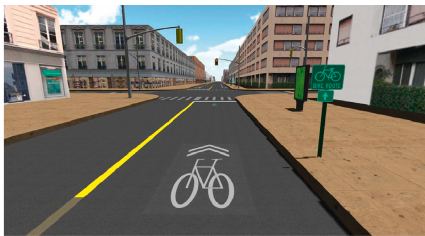
Figure 4: Example of the first person perspective from a human